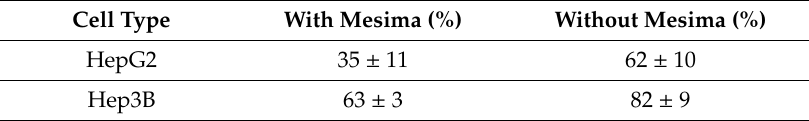
Table 3. The plating e ffi ciencies for controls with and without mesima.